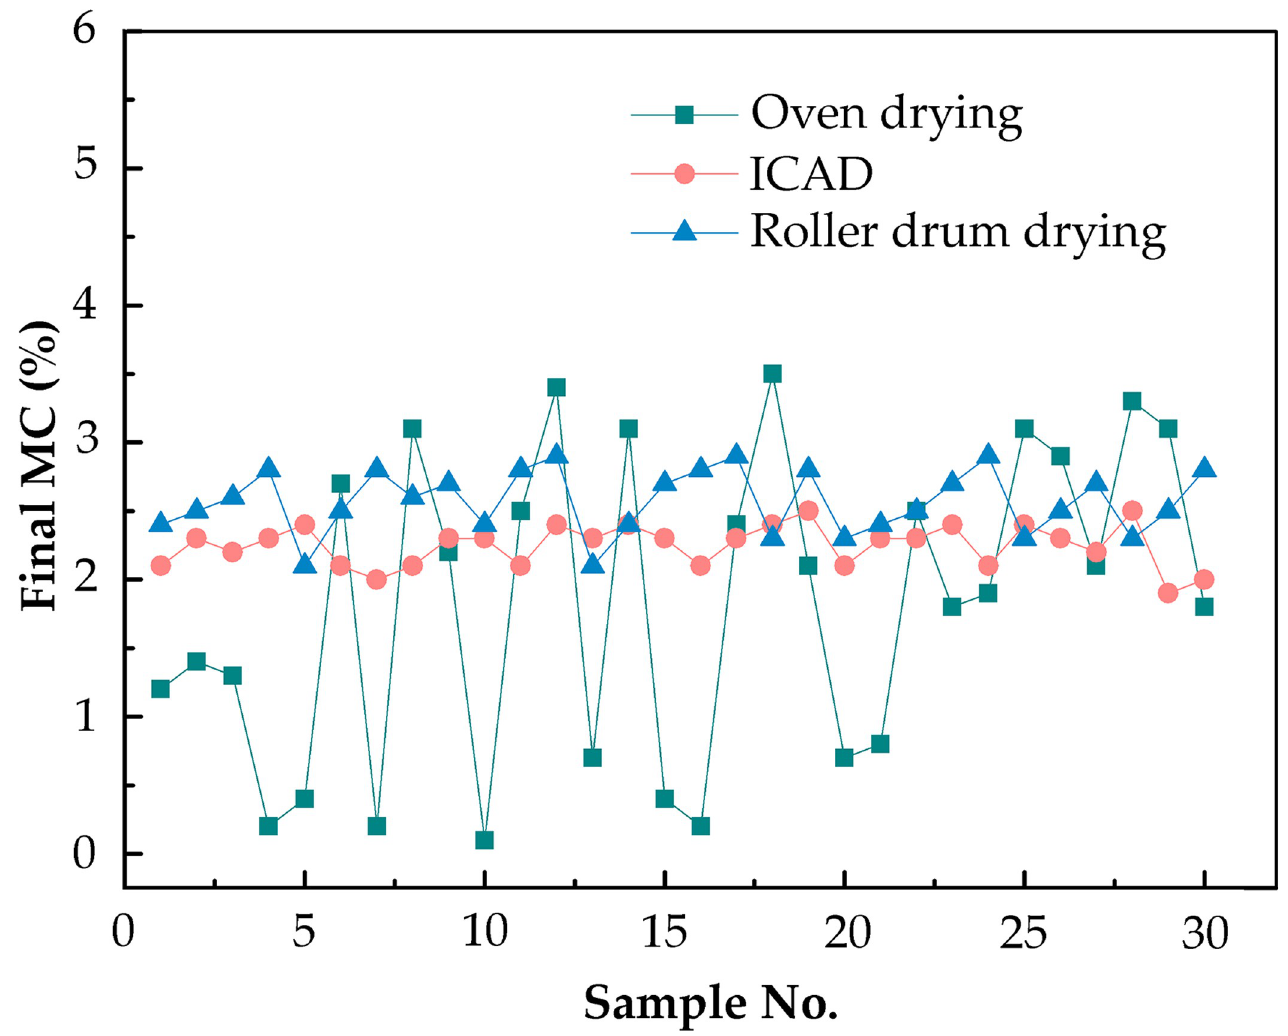
Fig 11. Final moisture content by different drying method.